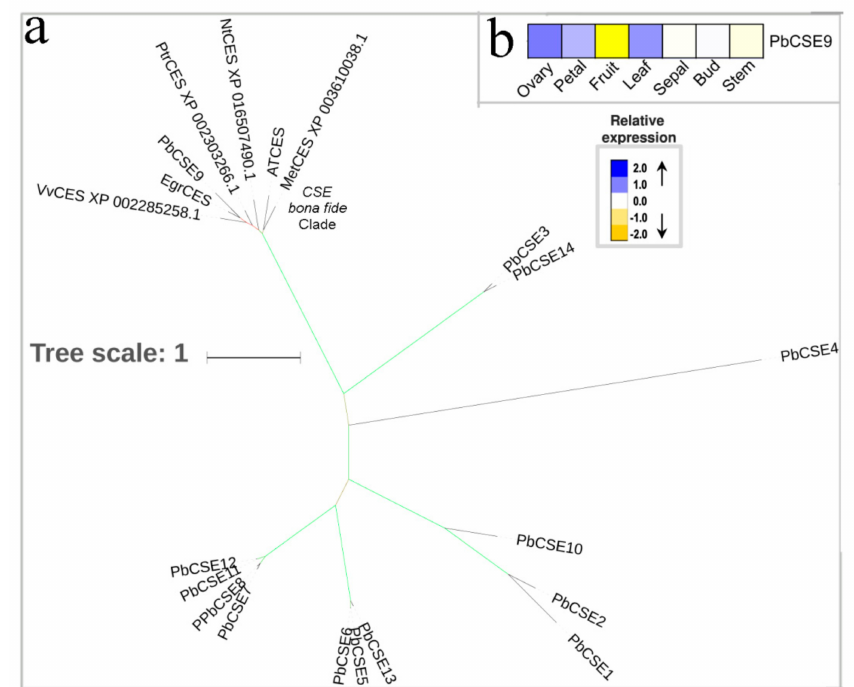
Figure 7. Phylogenetic tree and expression profiles of the CSE bona fide clade. ( a ) ML tree built with CSE bona fide enzymes from several species. ( b ) The expression profiles P. bretschneideri CSE bona fide genes. The green color of the tree branches suggests strong node support (bootstrap support ≥ 95% and SH-aLRT ≥ 75%). The FPKM values of PbCSE genes in di ff erent tissues are indicated in Table S3. The tree scale is the number of amino acid substitution per